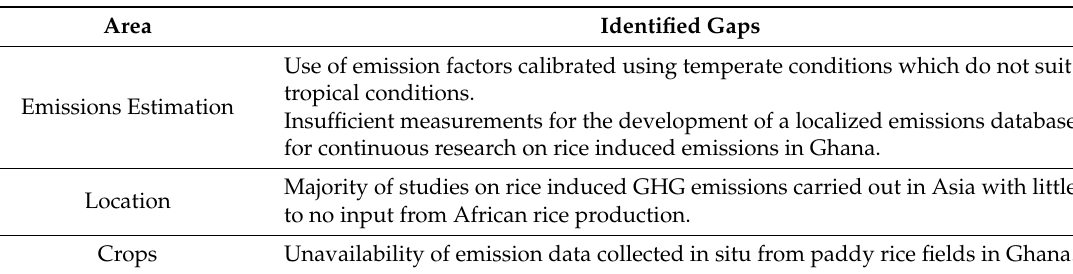
Table 1. Identified gaps in reviewed